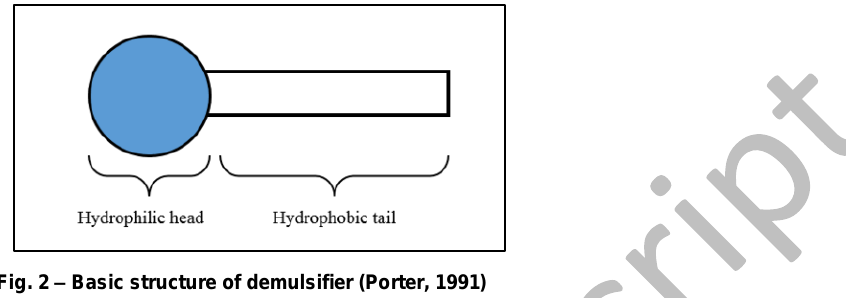
Fig. 2 – Basic structure of demulsifier (Porter,